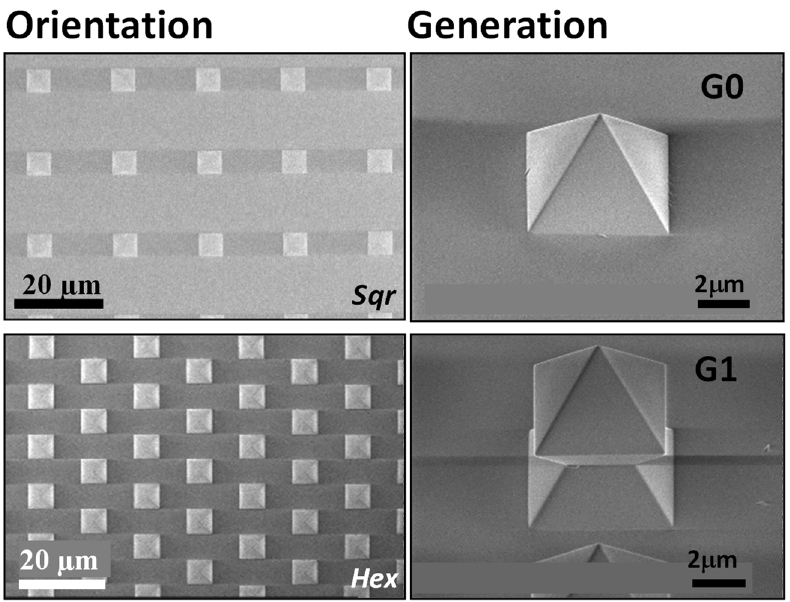
Figure 1. SEM images of the topographic structures increasing in self-similarity and complexity between generations.